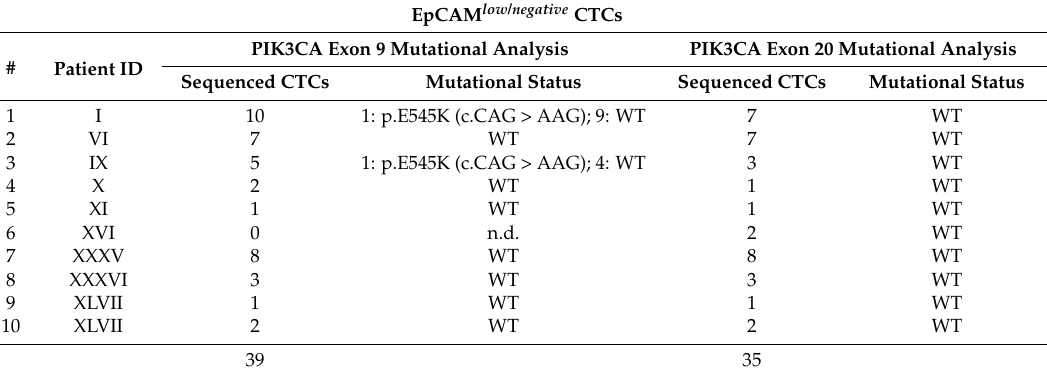
(Figure 5) as well as tumor cells carrying the WT form of the gene.